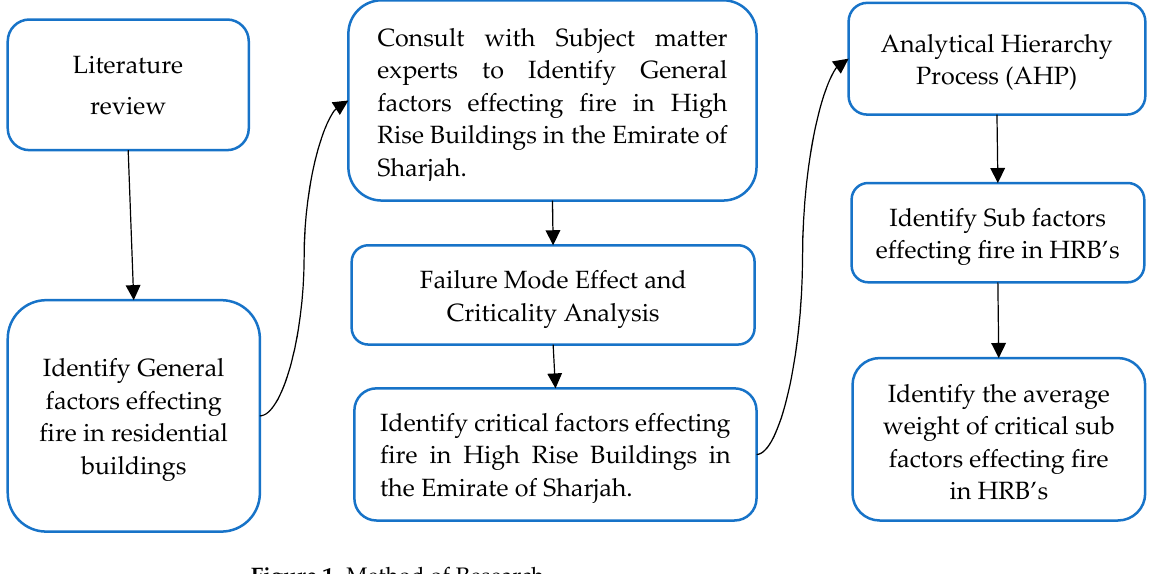
Figure 1. Method of